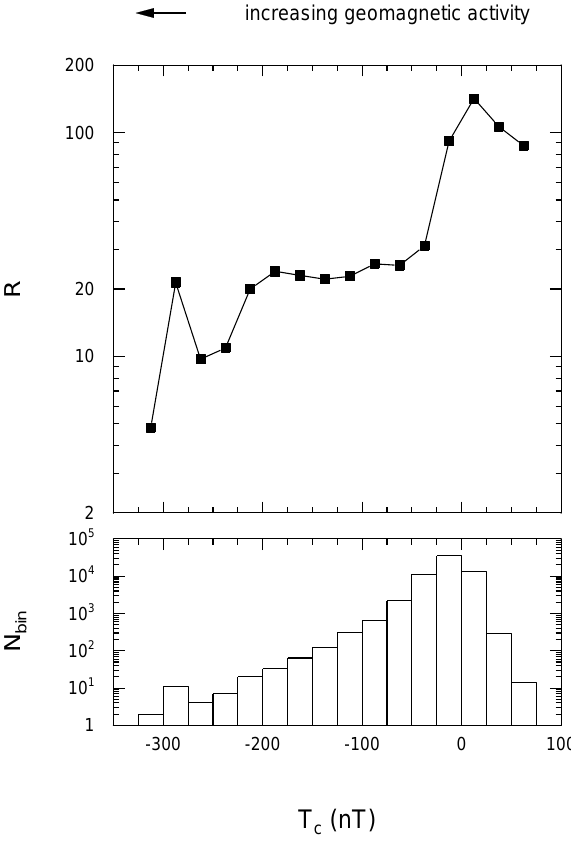
Fig. 3. Upper panel: relative error R for the EDDA algorithm, as defined in Eq. (4), calculated over the whole test set, and plotted against T c (see details in text). Lower panel: number of points over which each R is